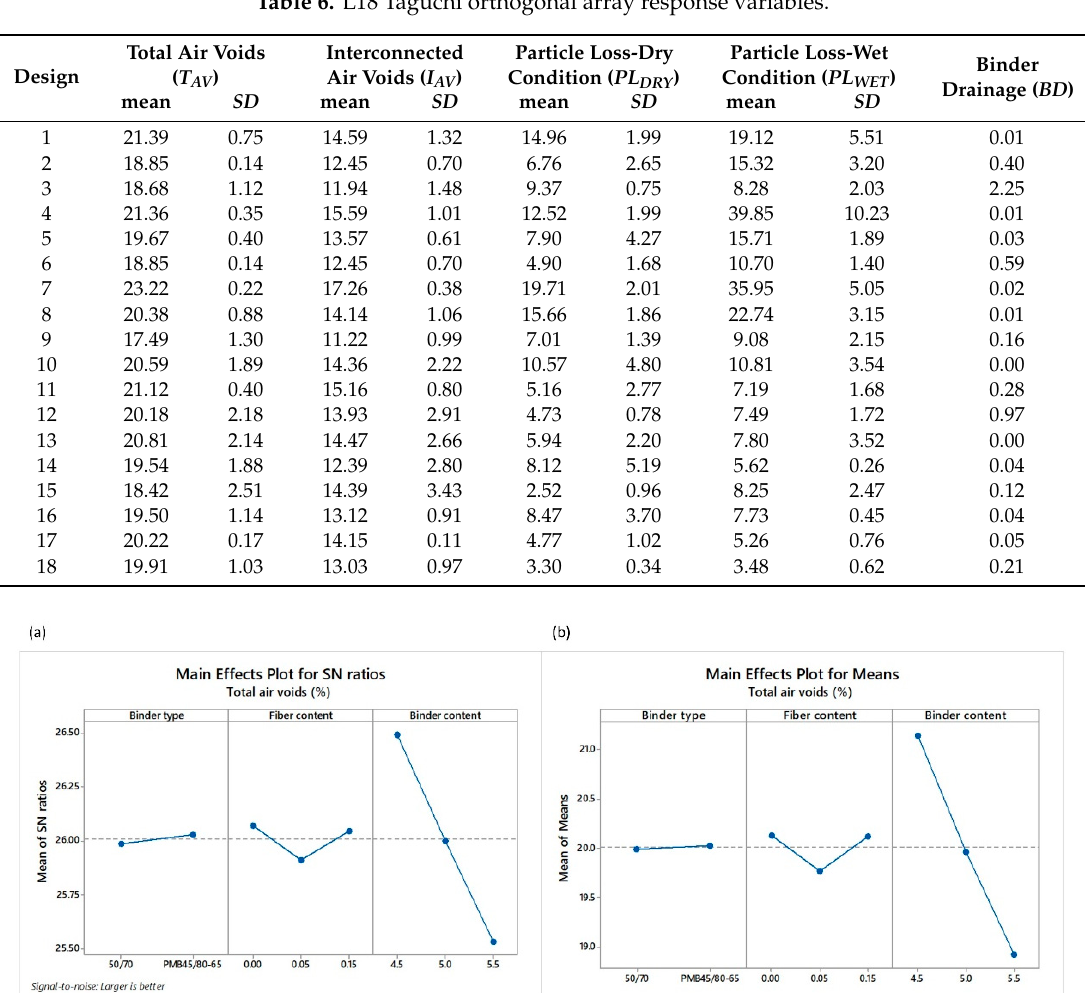
Figure 5. Main effects plots of ( a ) SNR and ( b ) means of the interconnected air voids I AV .